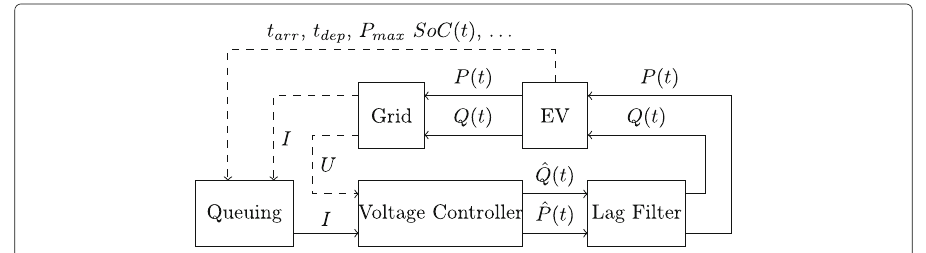
Fig. 6 Control flow in the co-simulation, where dashed lines are time